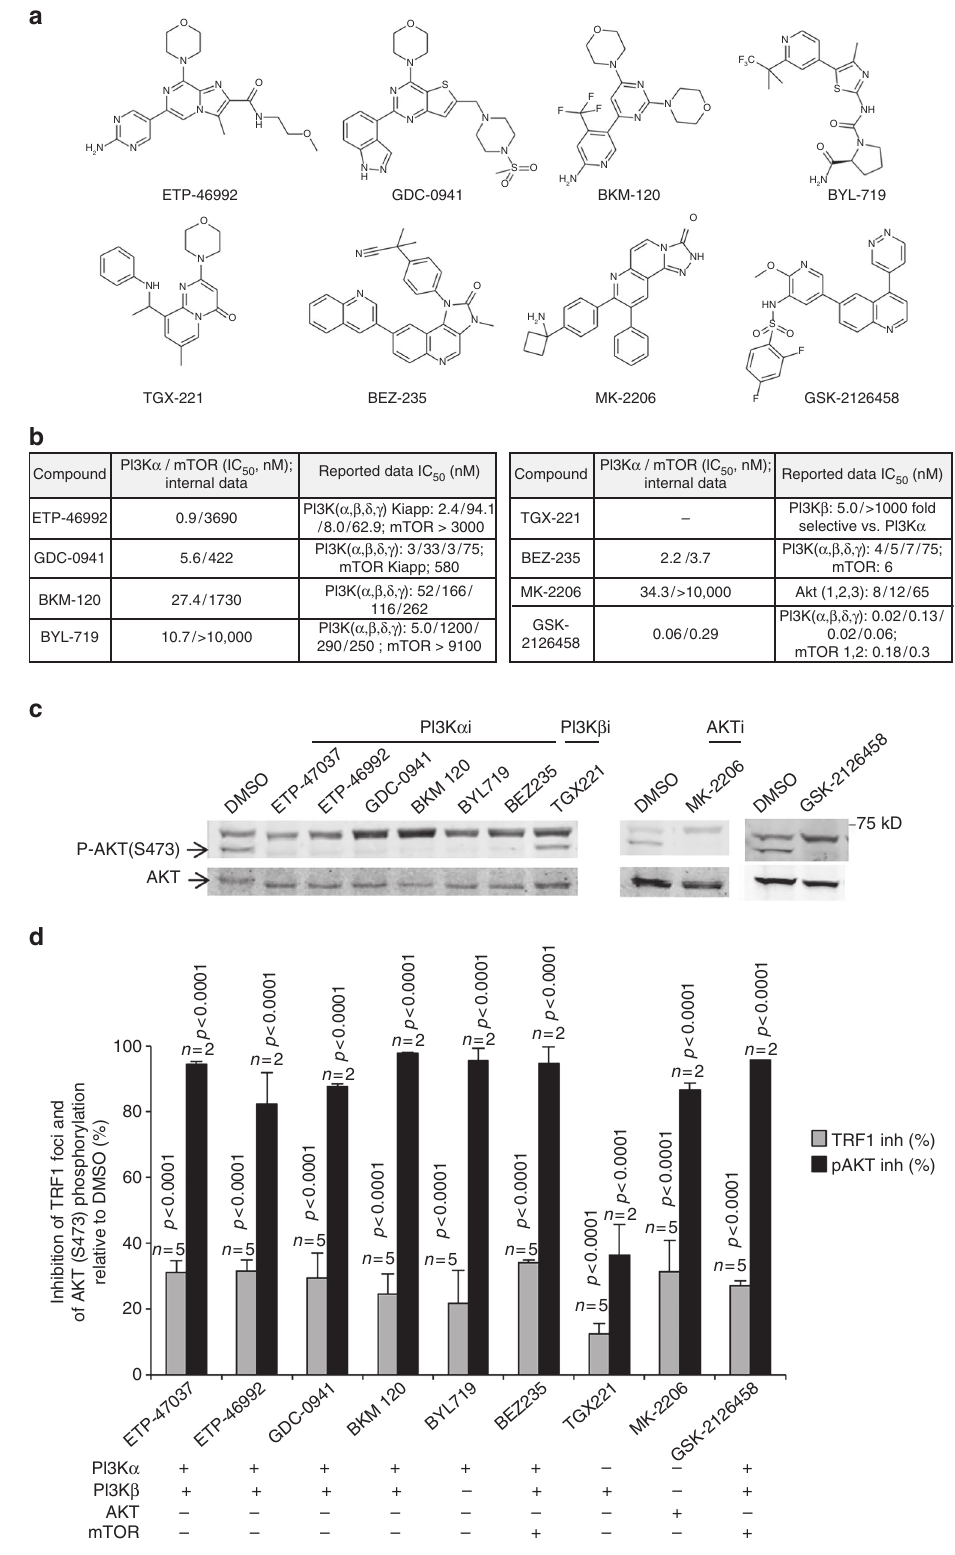
Fig. 2 TRF1 regulation by PI3K and AKT inhibitors. a Structurally diverse PI3K and PI3K/mTOR inhibitors used in the study. b PI3K and mTOR data generated internally and reported in literature. c Representative western blot images of phosphorylated AKT-Ser473 and total AKT in CHA-9.3 mouse lung tumor cell line at 24 h after treatment with PI3K, AKT, and mTOR inhibitors as indicated. d Percent inhibition of TRF1 foci by immuno fl uorescence and of AKT phosphorylation at S473 (pAKT) in CHA-9.3 mouse lung tumor cell line at 24 h after treatment with the indicated inhibitors relative to TRF1 levels and to pAKT levels in control cells treated with DMSO. The inhibitors were tested at 10 μ M except GSK-2126458 that was used at 1.0 μ M (in c and d ). Error bars represent standard deviation. The Student ’ s t test was used for statistical analysis; P values are shown. n number of independent